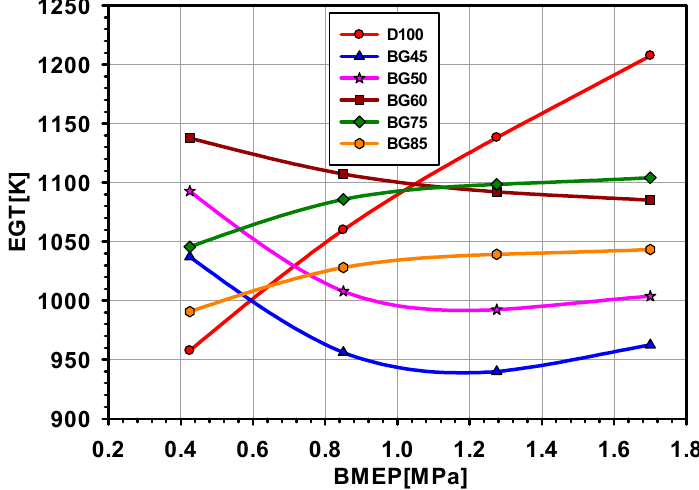
Figure 7. Variations of Exhaust gas temperature (EGT) with load for D100 and biogas-diesel